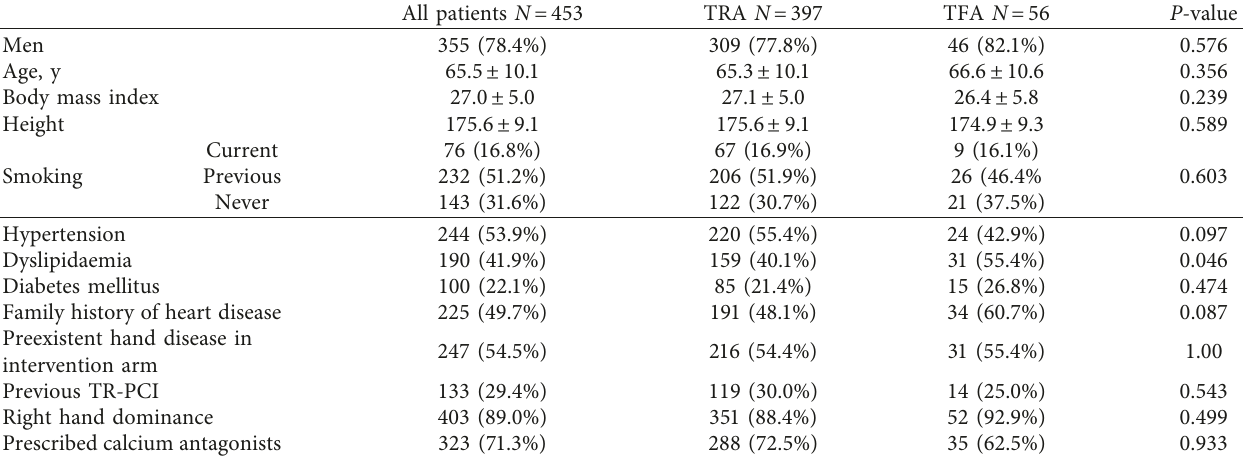
Table 3: Baseline characteristics of the total study